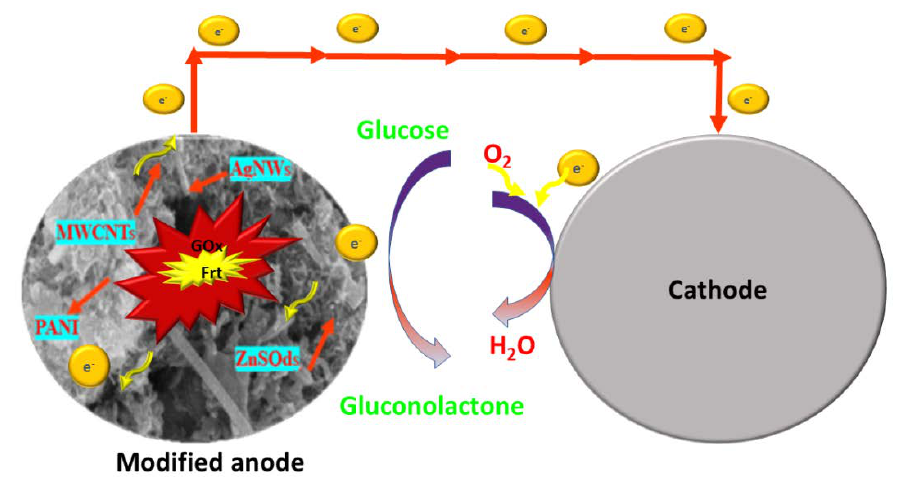
Figure 1. Illustrates the modified bioanode, depicts the shuttling of electrons via a biochemical